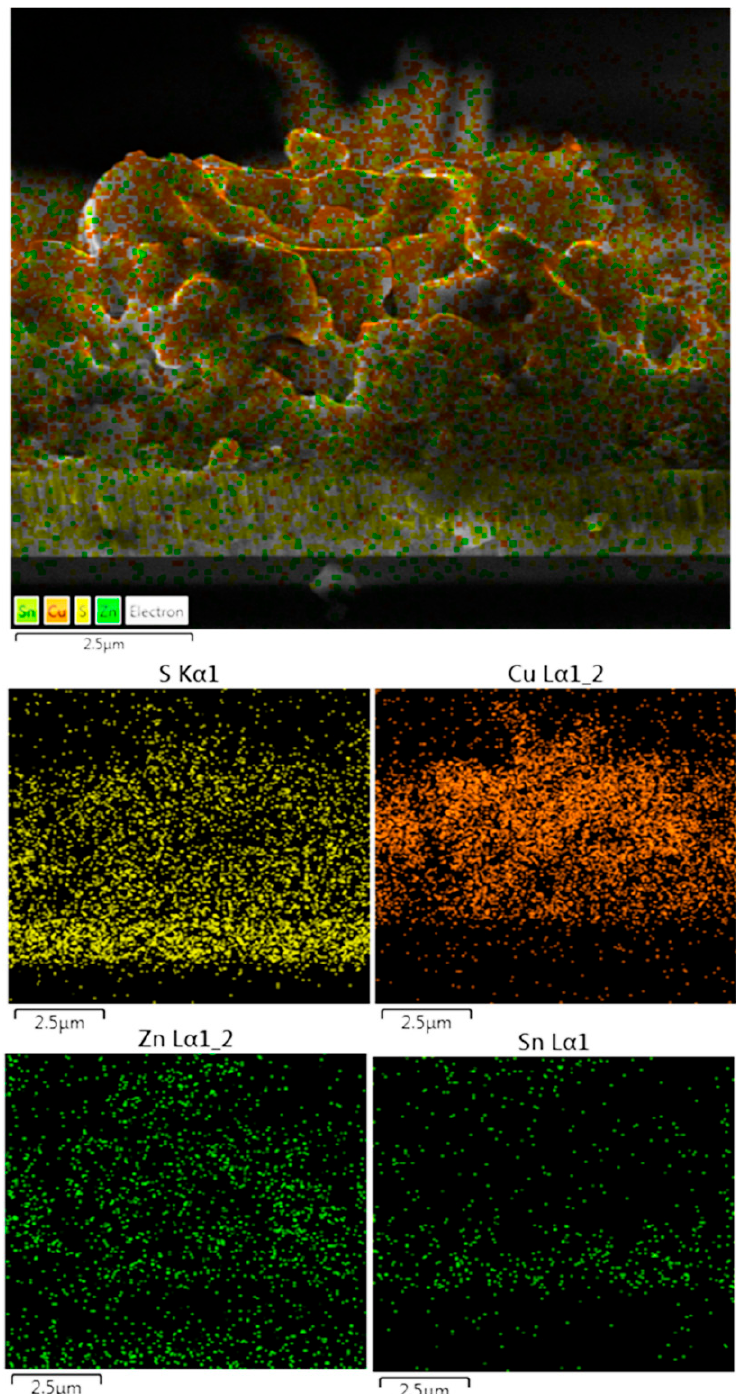
Figure 7. Microstructure evolution and energy dispersive spectroscopy (EDS) composition mapping of the DIO-20 mg/mL thin-film cross-section.